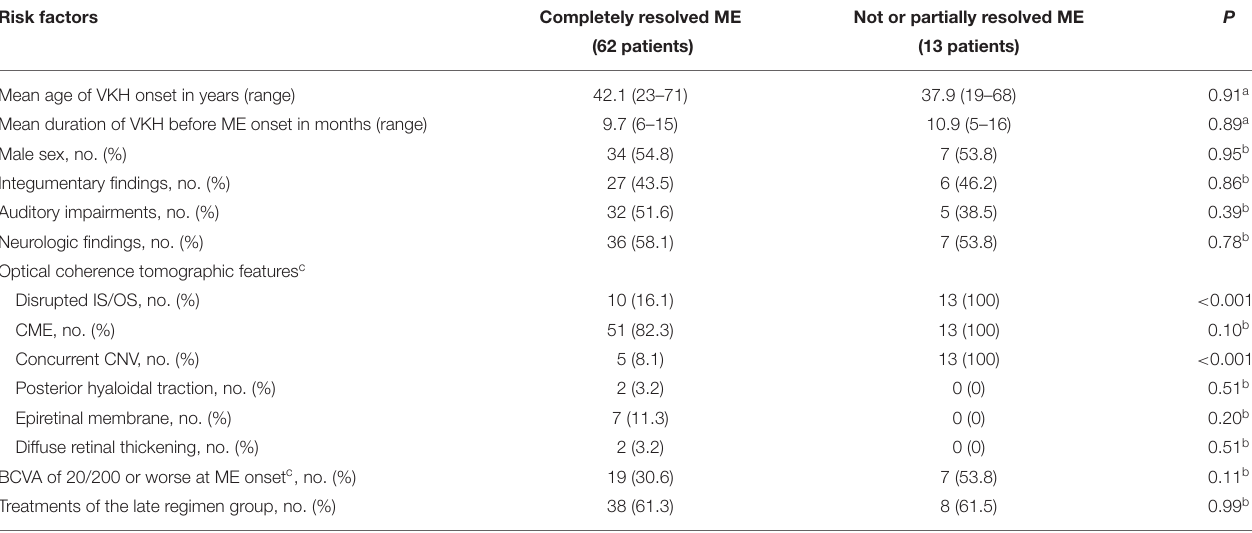
TABLE 2 | Demographic and optical coherence tomographic risk factors for developing persistent ME in VKH patients. Risk